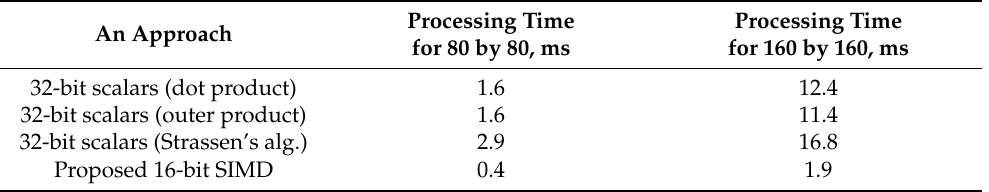
Figure 9. Processing time for matrix multiplication of 16.16 fixed point numbers via 32-bit scalar instructions and by means of 16-bit vector instructions depending on matrix size. Table 1. Processing time of various matrix multiplication approaches for matrix sizes 80 by 80 and 160 by